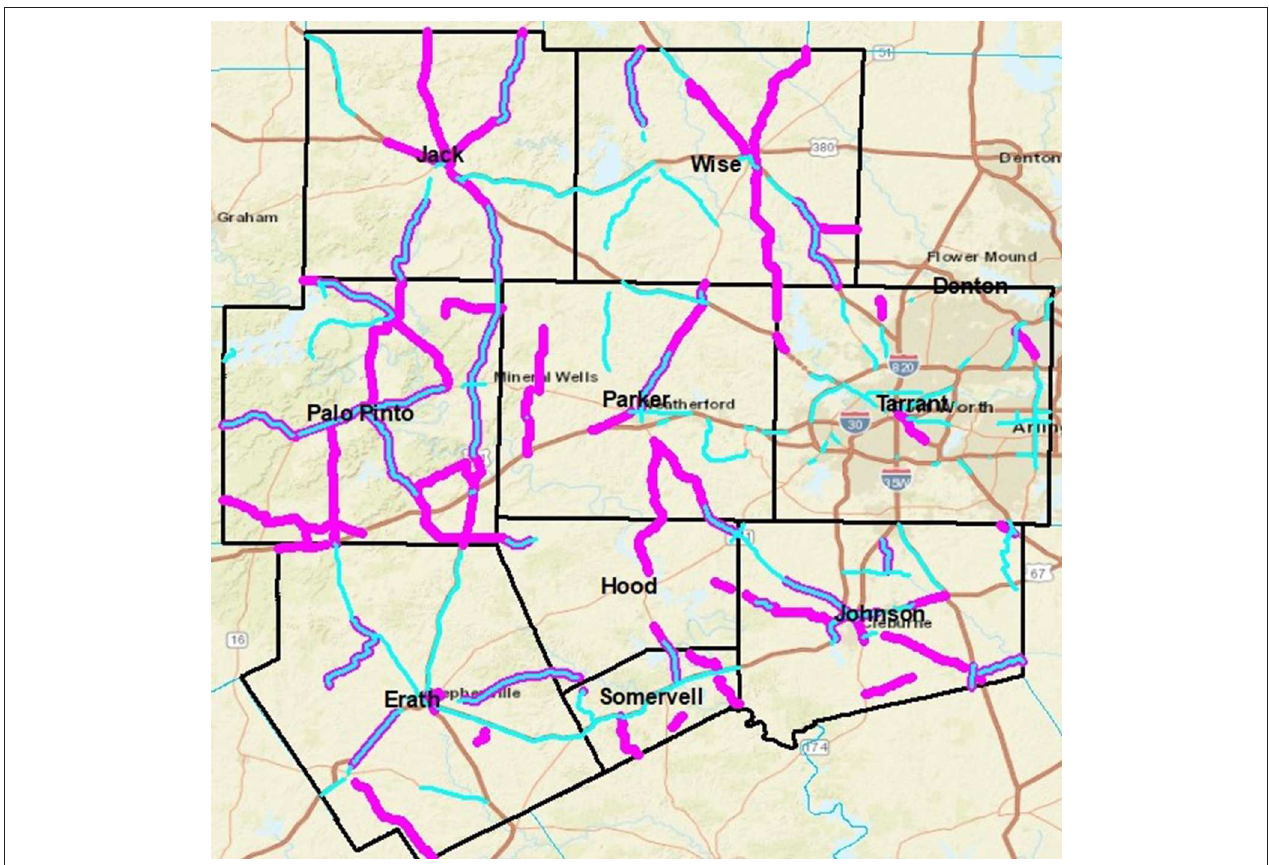
FIGURE 8 | GIS Map representing the projects planned by maintenance and capital groups.